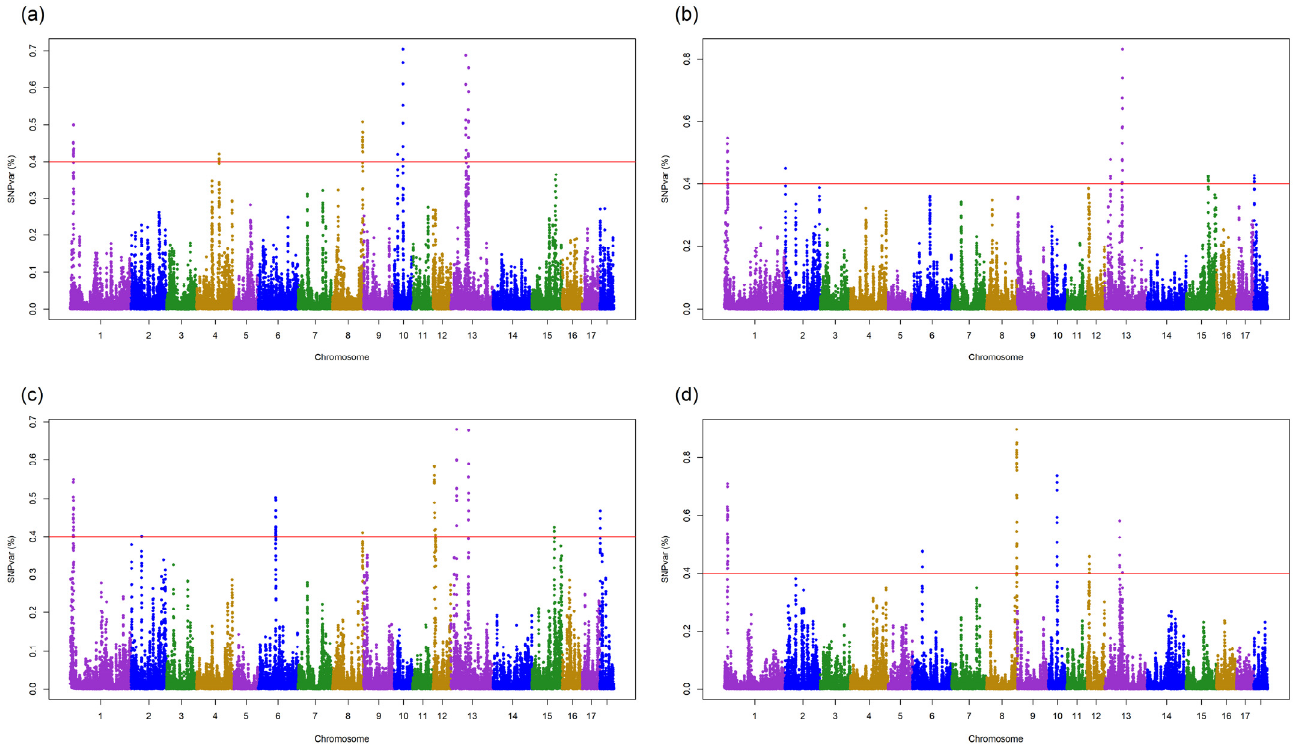
Figure 1. Results of single-step GWAS for DGE and SGE on average daily gain (ADG) in DUC and crossbred pigs. SNPvar (%) is the variance explained by SNPs within 0.4 Mb-sized windows: single-step GWAS plot for DGE on ADG in ( a ) DUC and ( b ) crossbred pigs; single-step GWAS plot for SGE on ADG in ( c ) DUC and ( d ) crossbred pigs. The horizontal line (red) represents the threshold of explained variance (0.4%).